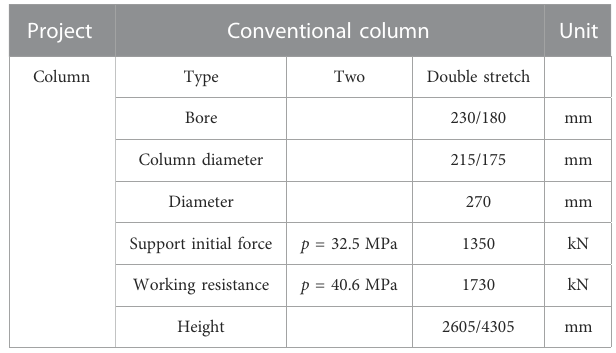
TABLE 5 Parameters of the conventional